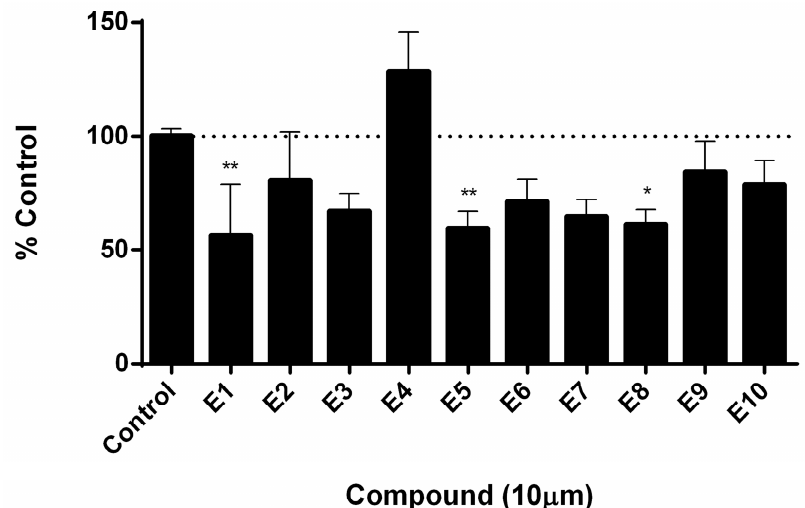
Figure 8. Determination of telomerase activity by qPCR. Quantification of telomerase activity was carried out by real time PCR with specific primers, using a protein extract from treated and untreated telomerase positive cells as a template for 48 h. Dashes line indicates the 100% of the control. Values represent media ± SEM; n = 6, * p < 0.5 ** p < 0.01 vs. control (ANOVA followed by Dunnett).